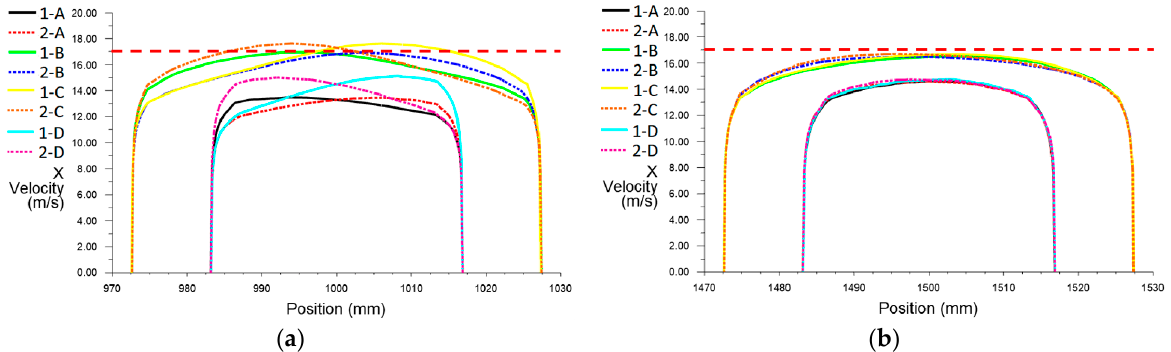
Figure 17. Velocity distributions on individual paths with FC. ( a ) 10D; ( b ) 15D.